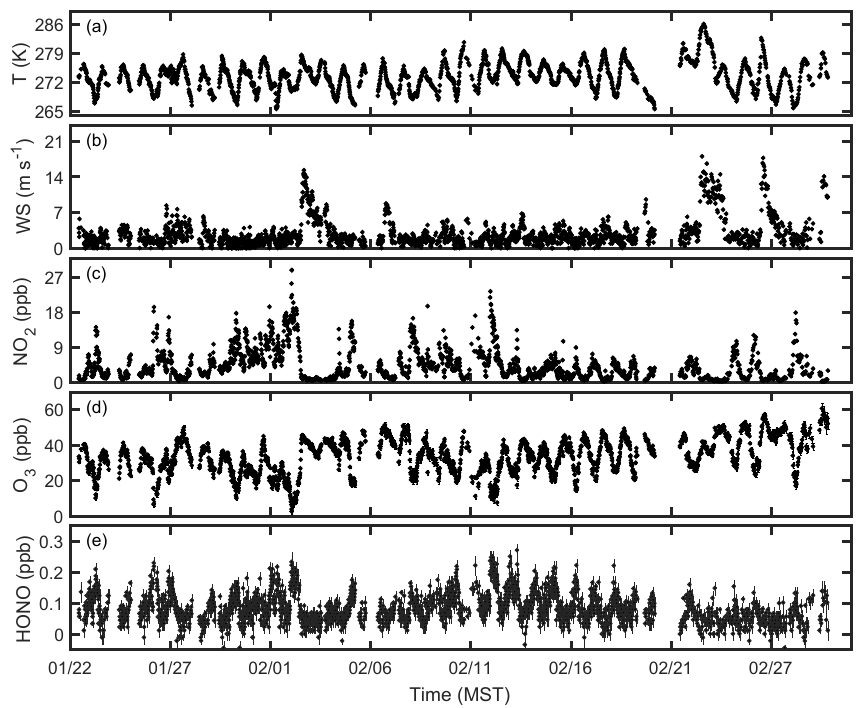
Figure 4. Overview of meteorological parameters (a, b) and mixing ratios of (c) NO 2 , (d) O 3 , and (e) HONO observed on the lower light path throughout the study. Error bars in the trace gas panels (a–e) denote the statistical error of each observation derived by the DOAS analysis. Please note that the NO 2 and O 3 error bars are smaller than the data